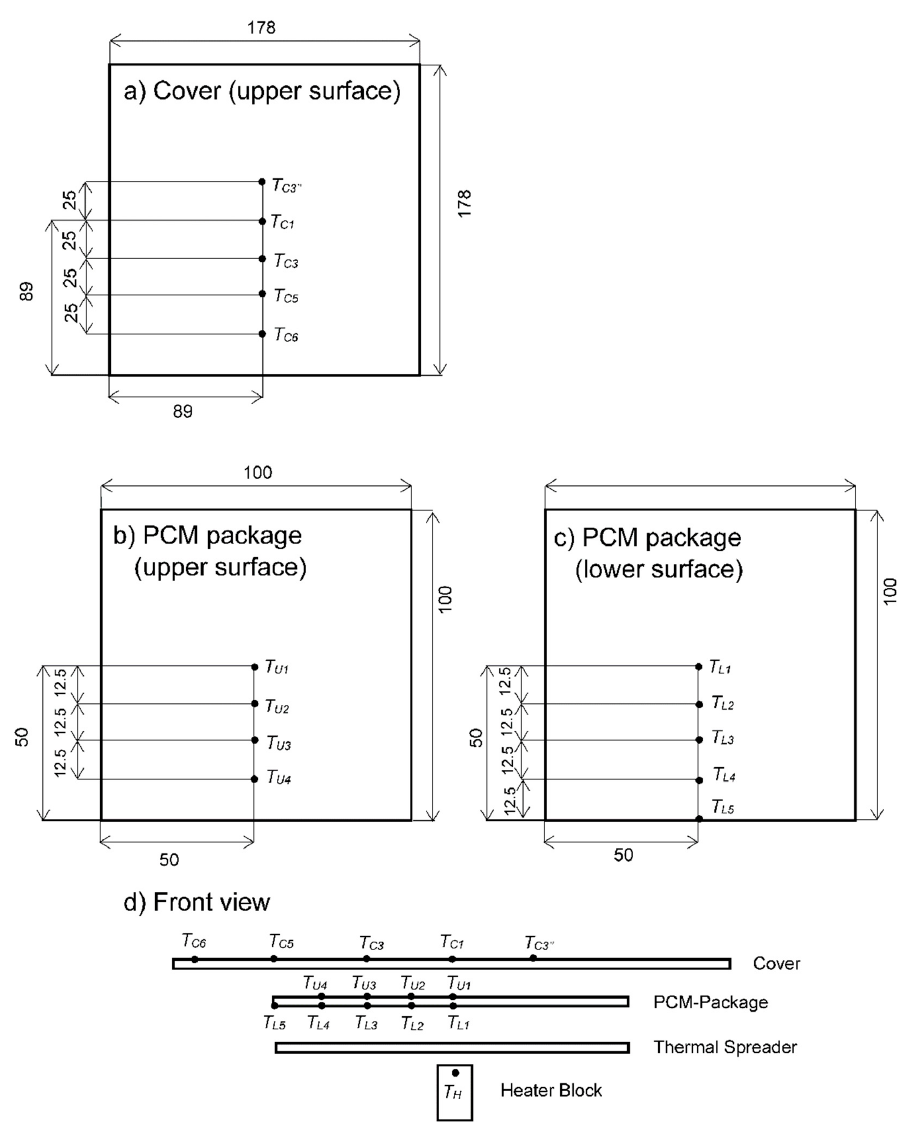
Figure 3. Location of the thermocouples mounted on ( a ) the upper surface of the cover, ( b ) the upper surface of the PCM package, ( c ) the lower surface of the PCM package, with ( d ) an overview of the mounted thermocouples (all dimensions are given in mm).